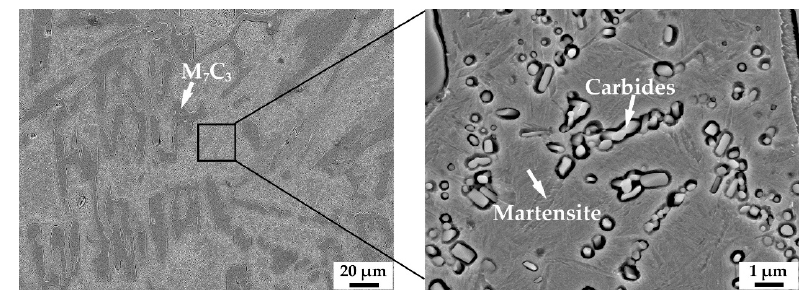
Figure 3. SEM micrograph of HCCI and corresponding magnified micrograph.